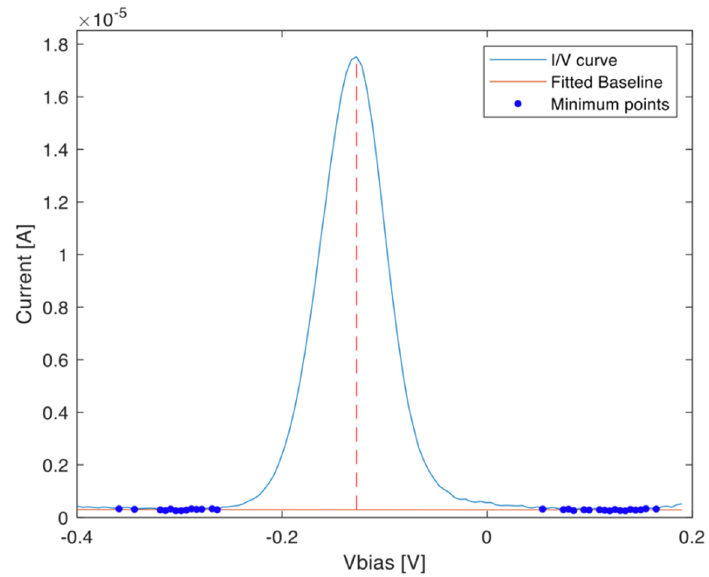
Figure 3. Example of baseline estimation from a voltammogram. Thirty minimum points were considered for the linear regression.